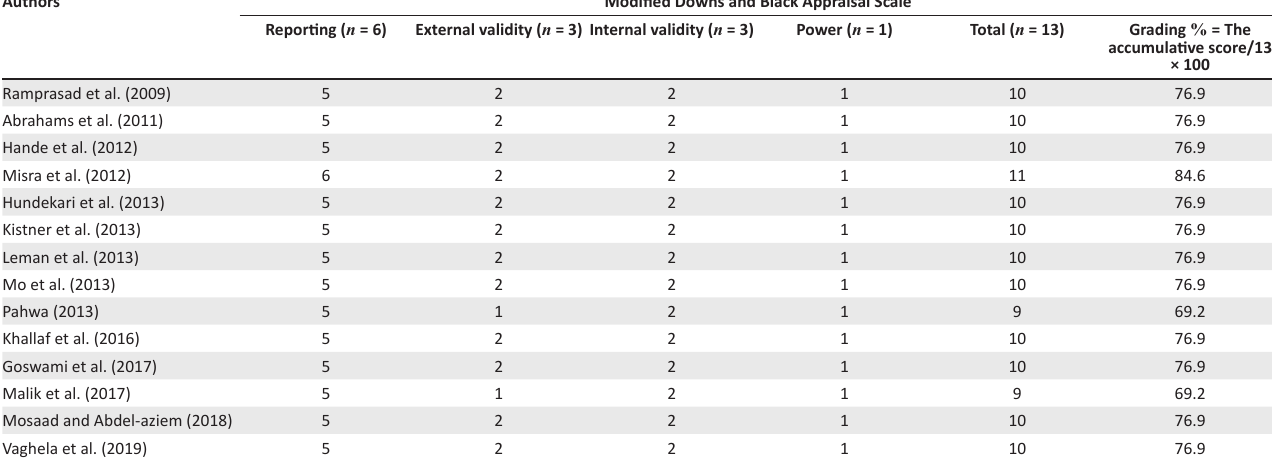
TABLE 3: Results of the evaluation of records pertaining to schoolbag carriage cervical posture amongst students during the period of 2009–2019 ( n = 14). Authors